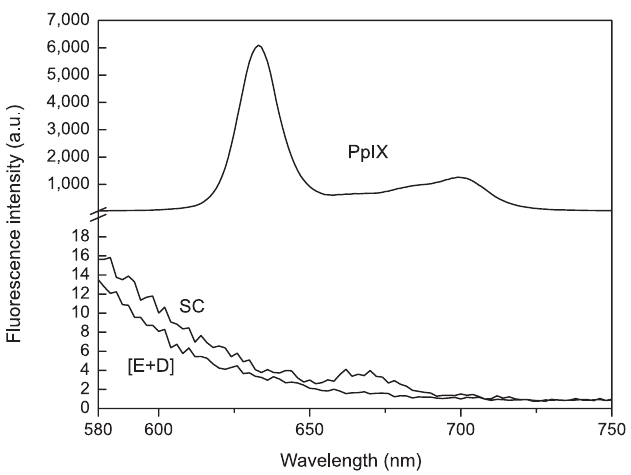
FIGURE 3 - Spectra referring to analyses of homogenates of SC and [E+D] in comparison to the profile of a 5 μg/mL PpIX solution (DMSO) to evaluate the selectivity of the